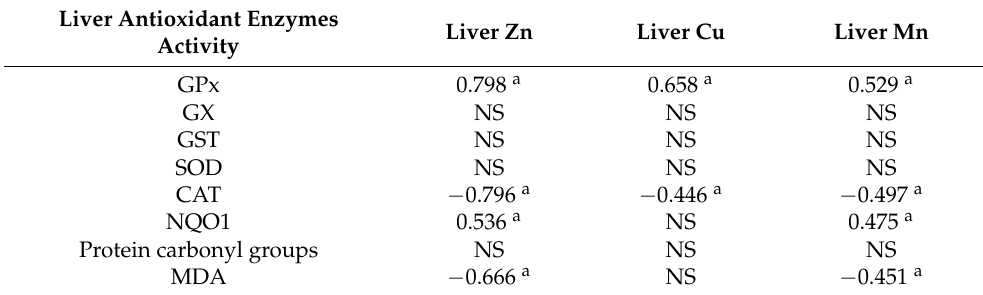
Table 4. Spearman’s rank correlation coefficient between liver antioxidant enzymes activity and Zn, Cu and Mn liver